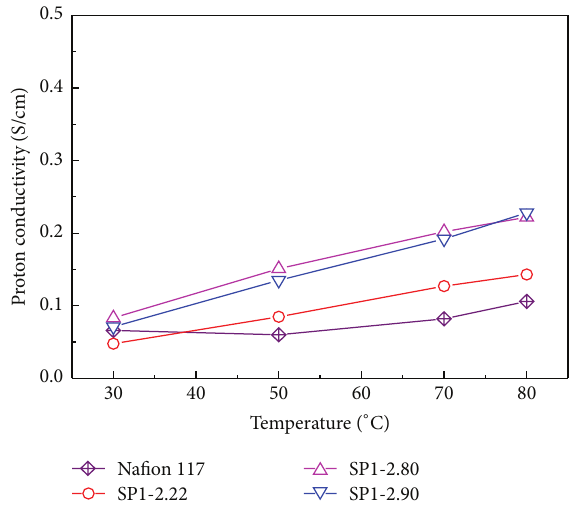
Figure 6: Proton conductivity of SP1- 𝑋 membranes as a function of temperature under 95% RH.